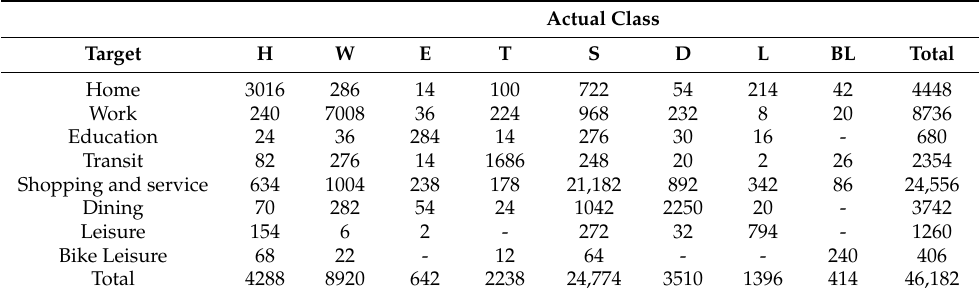
Table 8. Confusion matrix for statistical